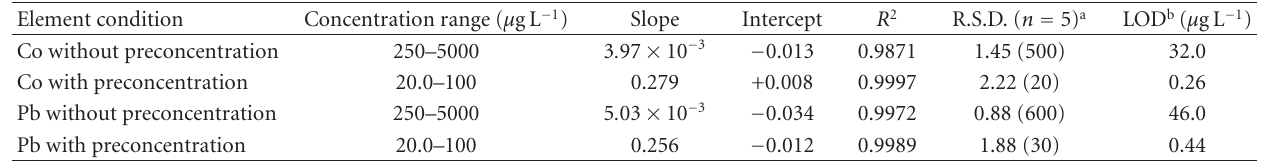
Table 2: Analytical characteristics of the proposed method.